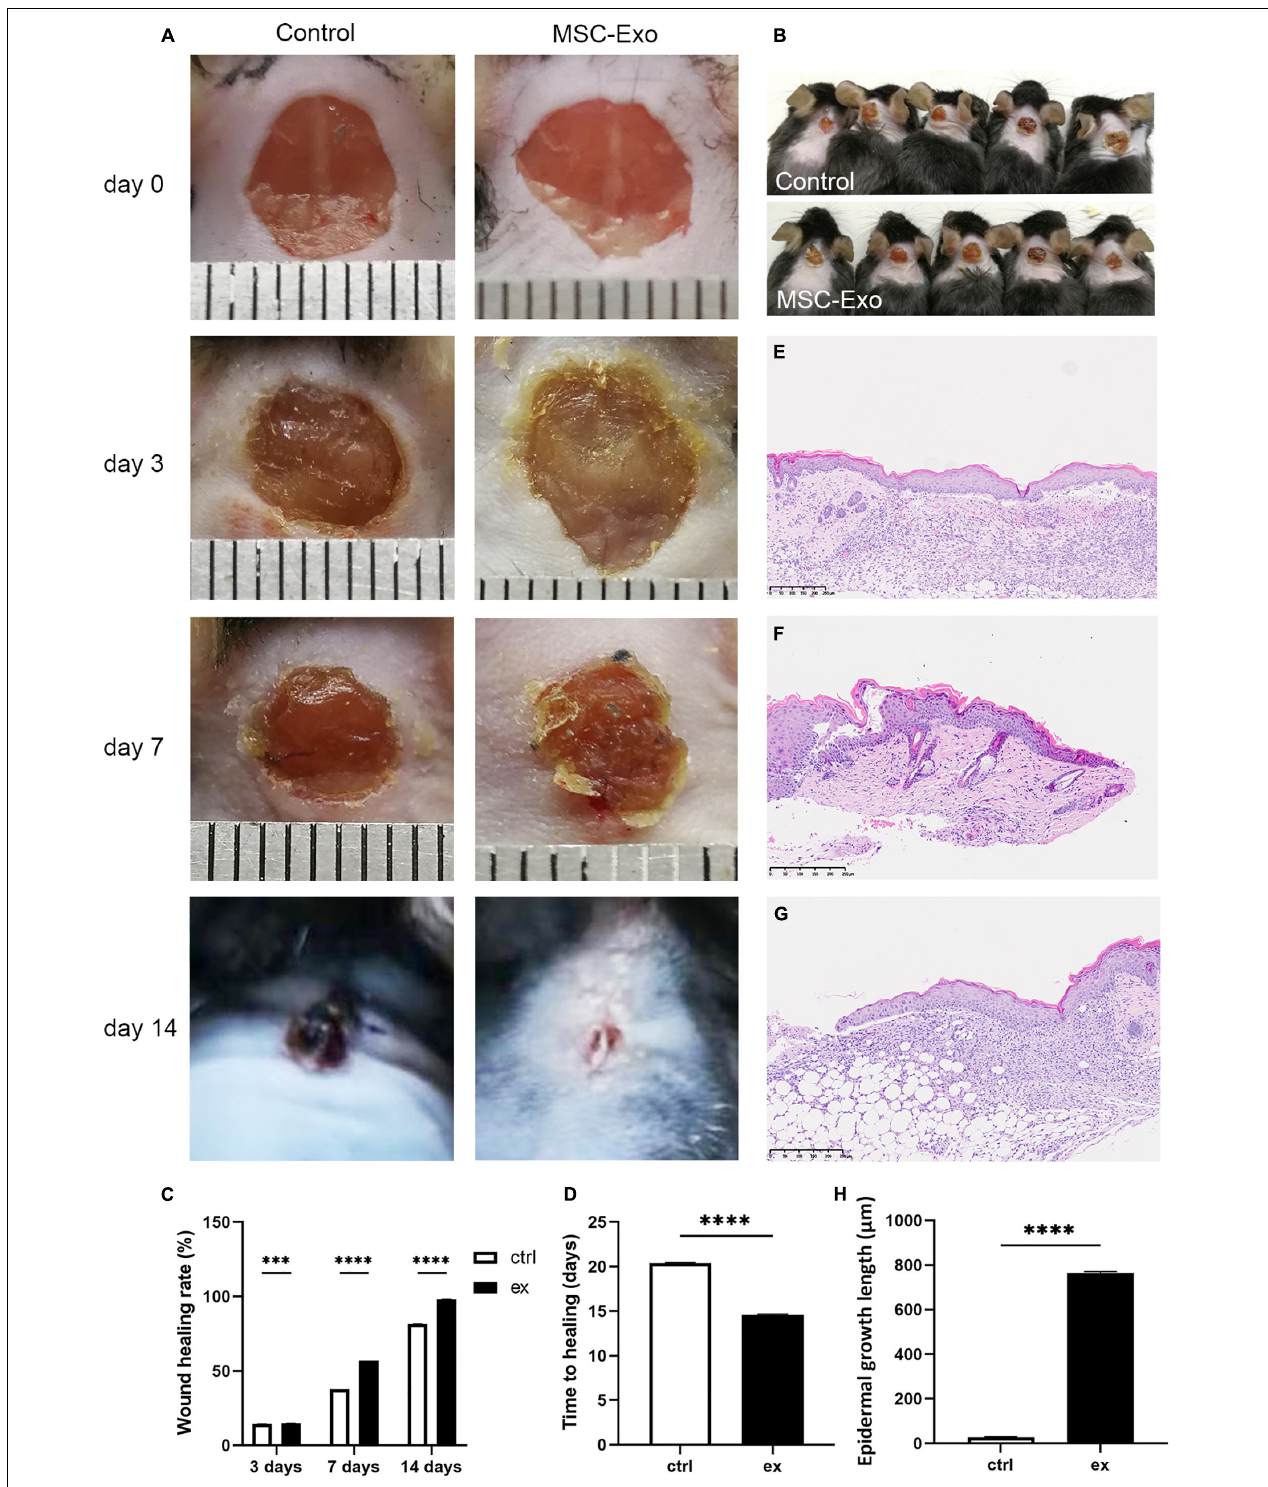
FIGURE 5 | UC-MSC-Exo accelerates wound healing. (A) Representative images of the wound healing process in mice treated with control and MSC-Exo. (B) Wound healing situation in mice at 7 days. (C) Wound healing rate of experimental and control group. *** p < 0.0001, **** p < 0.0001. (D) Comparing of wound healing time after treatment with or without MSC-Exo. **** p < 0.0001. Histological features during healing of full-thickness skin wounds from normal mouse skin (E) , control mouse (F) and MSC-Exo mouse (G) . (H) Quantitative analysis of crawling distance after 14 days post-wounding. **** p < 0.0001, compared with the control group. Error bars indicate SDs of triplicate samples in a single representative